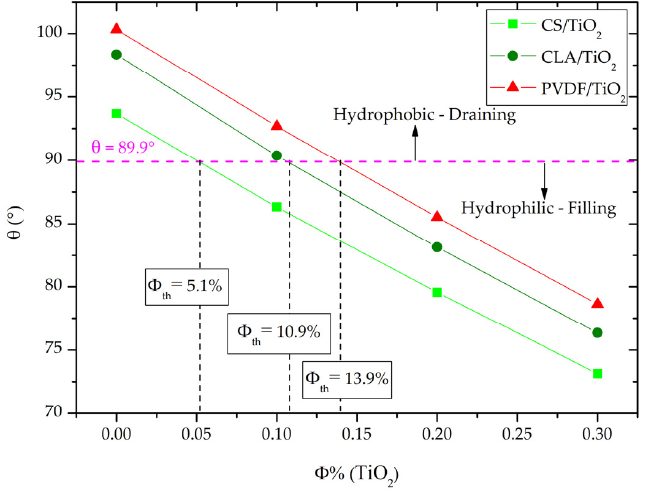
Figure 3. Water Contact angle of CS/TiO 2 , CLA/TiO 2 and PVDF/TiO 2 nanocomposites as function of volume fraction of TiO 2 NPs.